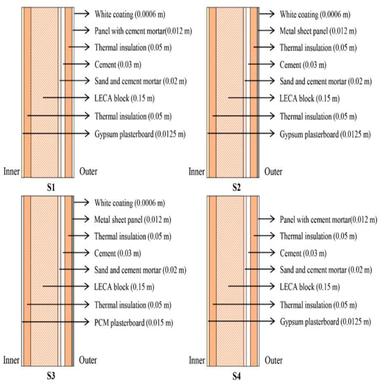
Proposed wall options for the existing south-facing facade with cement.